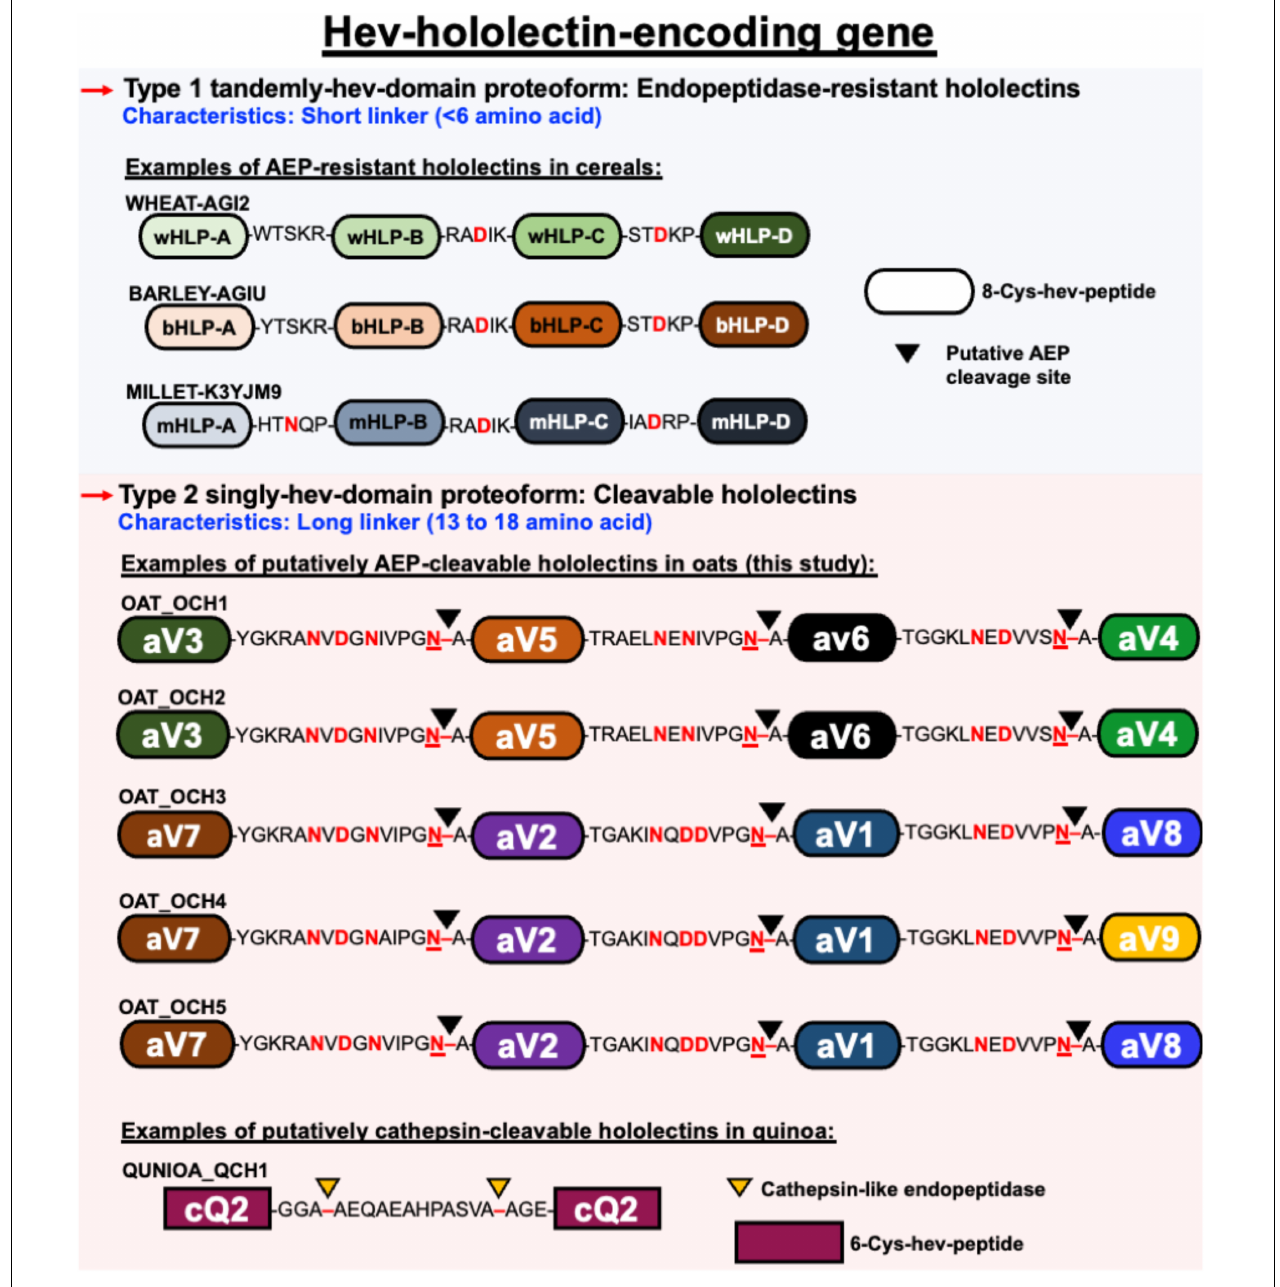
FIGURE 9 | Schematic representation of different architectural types of hev-hololectin. Type 1 proteoforms are endopeptidase-resistant hololectins that are presented as tamdemly hev-domains with short linkers. Endopeptidase-resistant hololectins can be found in wheat, barley and millet. Type 2 proteoforms are cleavable hololectins with long linkers which are presented as singly hev-domain. Putatively AEP-cleavable hololectins with flexible and Asx-rich linkers can be found in oats, and putatively cathepsin-cleavable hololectins with flexible Gly/Ala-rich linker can be found in